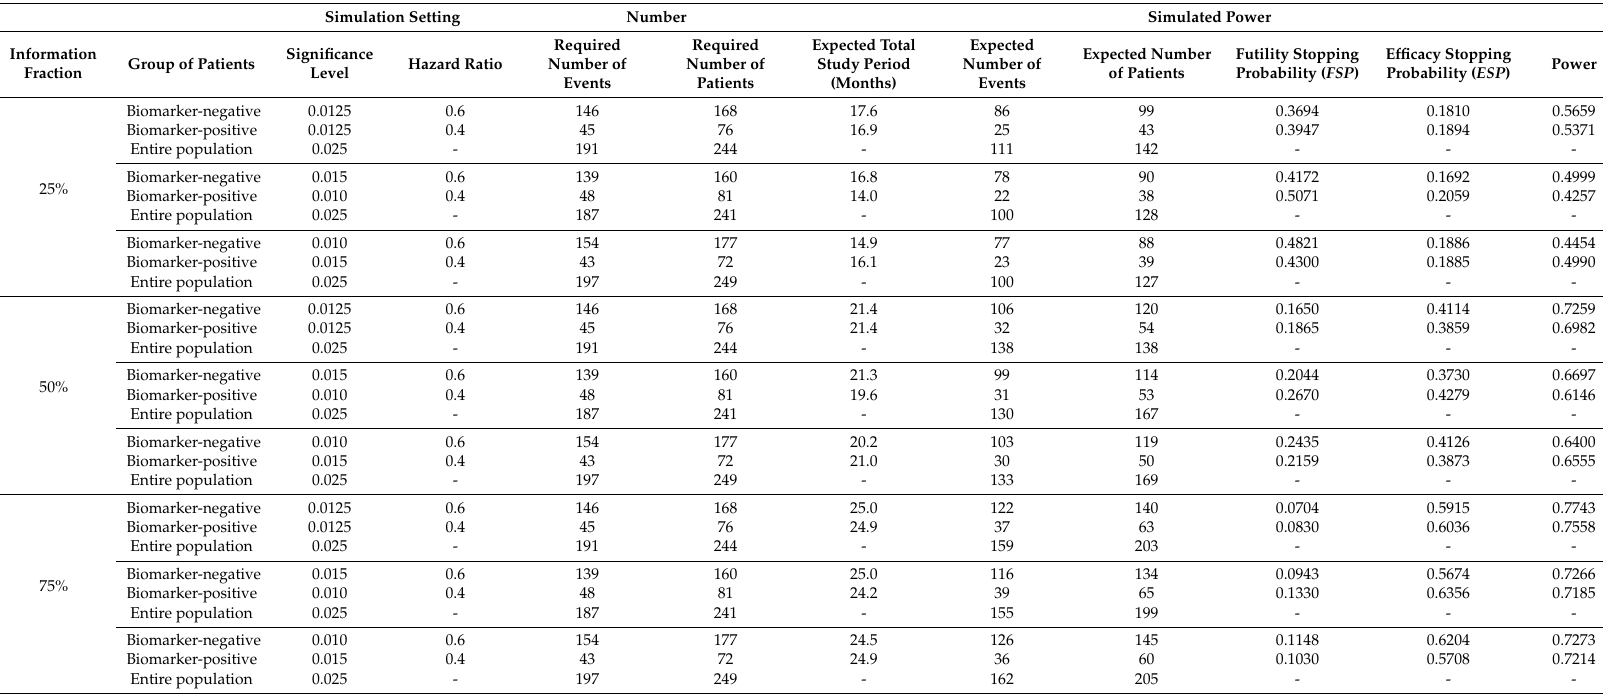
Table 1. Results for expected number of events and patients, expected total study period, futility stopping probability, efficacy stopping probability and power of a two-stage design in scenario 1 of hazard ratios for different percentages of information fraction. Number of events and patients from Table 1 (calculated from Equation (1) and Equation (3) respectively) which achieve 80% power for the first scenario of hazard ratios and significance levels are also